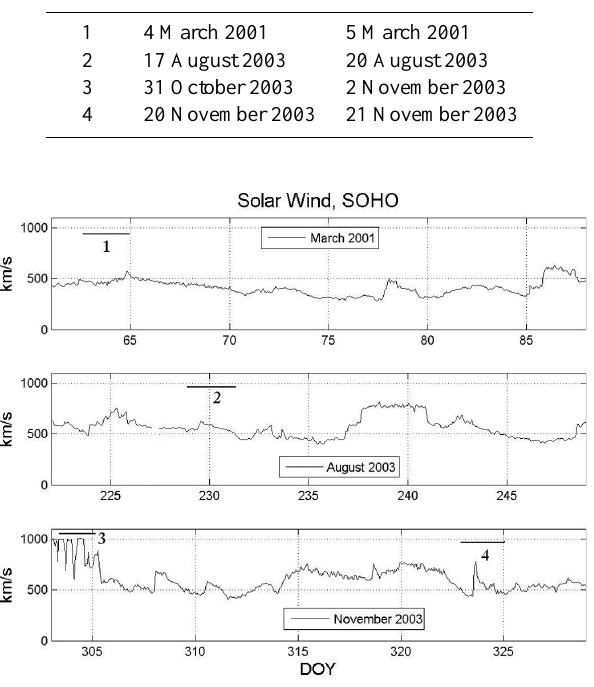
Fig. 2. Three time series of solar wind velocity for months shown in legends. The CME events also are indicated by a number and a short